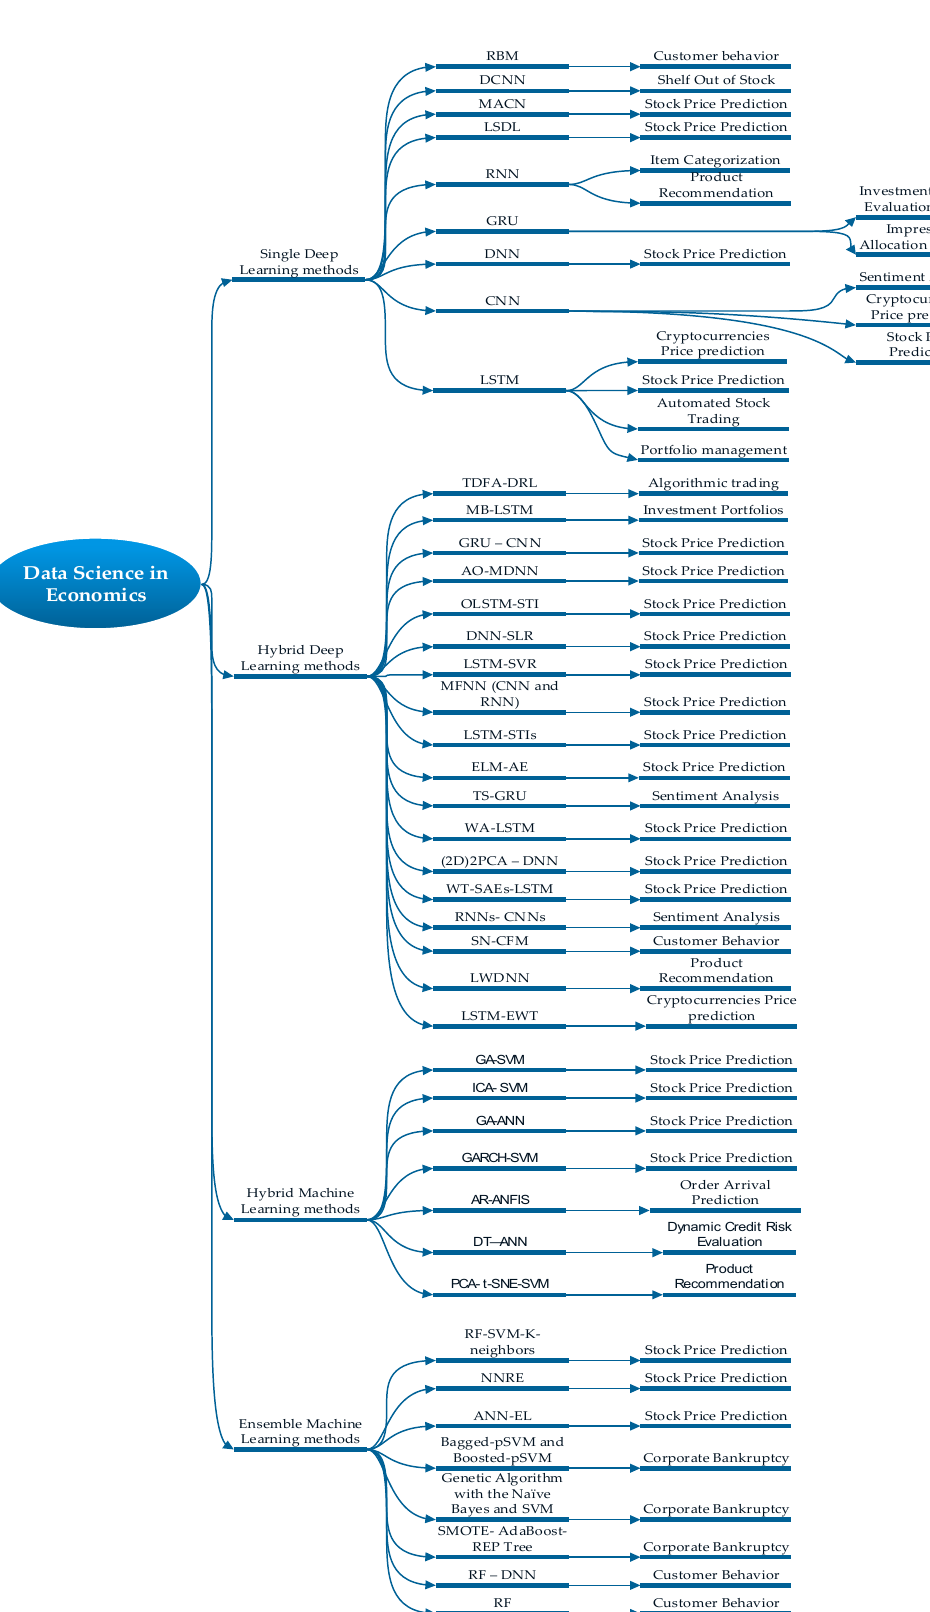
Figure 7. Taxonomy of data science methods (machine learning and deep learning) in economics.